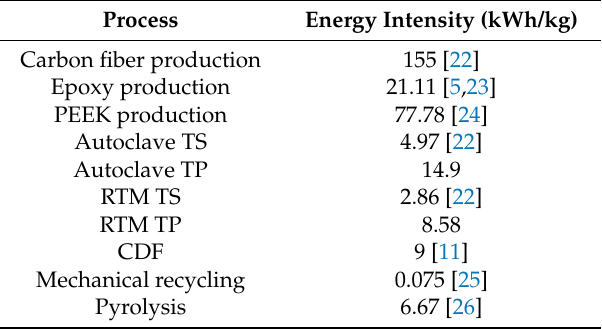
Figure 2. System boundaries. Table 1. Energy intensity of each